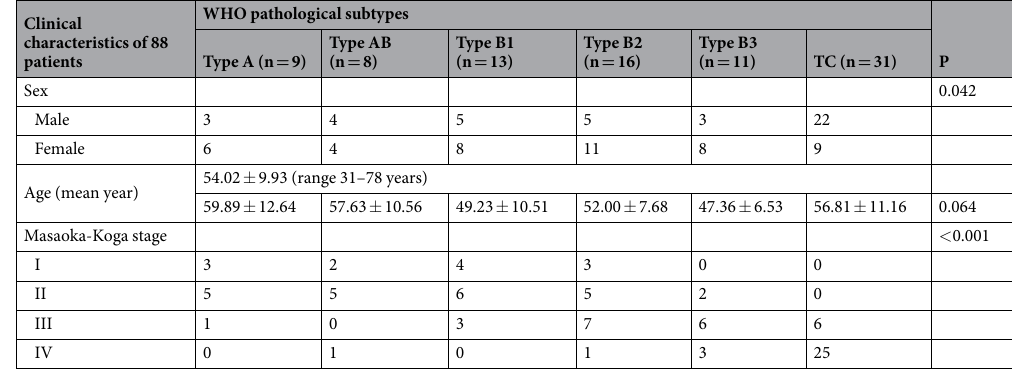
Table 1. Clinical characteristics of 88 patients. TC, thymic carcinoma.